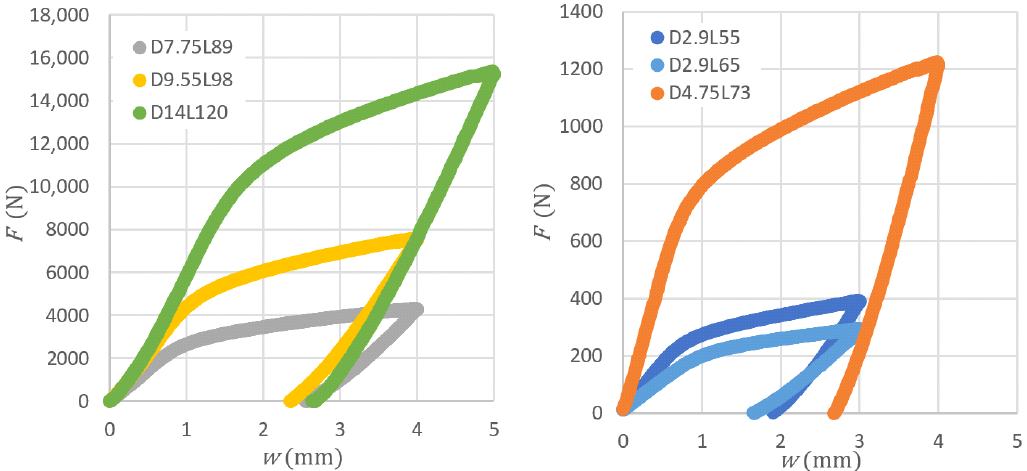
Figure 7. Force response to total deflection for all considered cases.